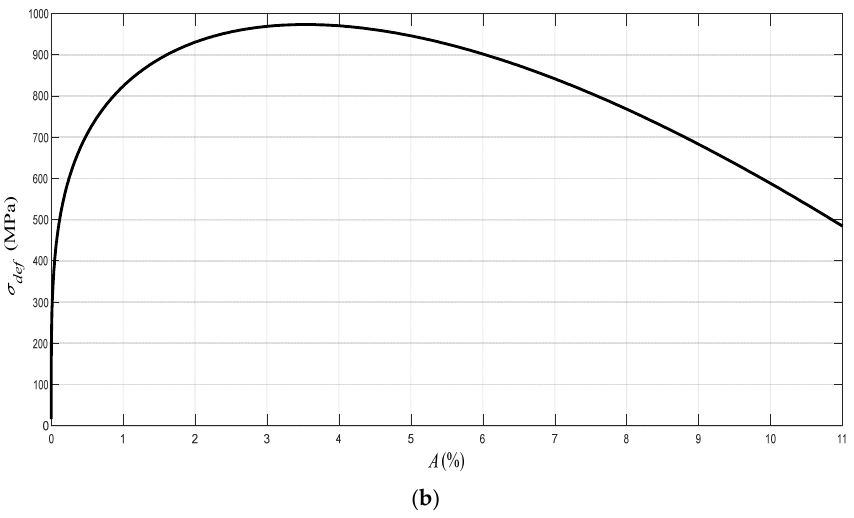
Figure 4. ( a ) Deformational diagram for the steel grade 15230QT for the dependence σ def = f ( A ) from tensile test; ( b ) Comparison diagram for the steel grade 15230QT; analytical construction of the dependence σ def = f ( A ).